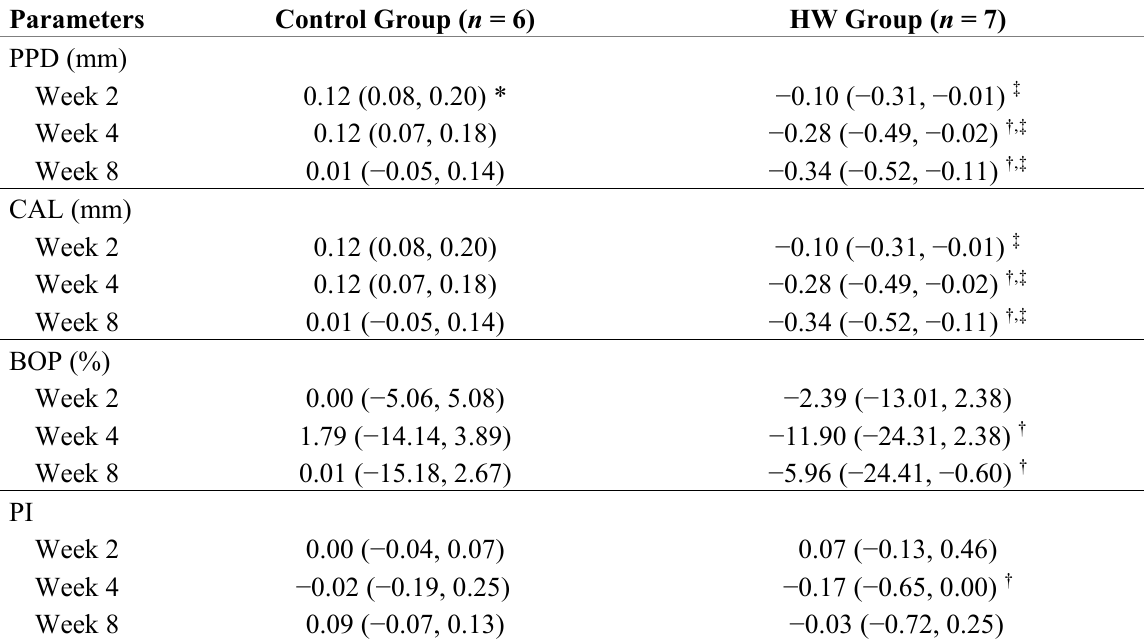
Table 2. Changes in clinical parameters at week 2, 4 and 8 (median (25%, 75%)).